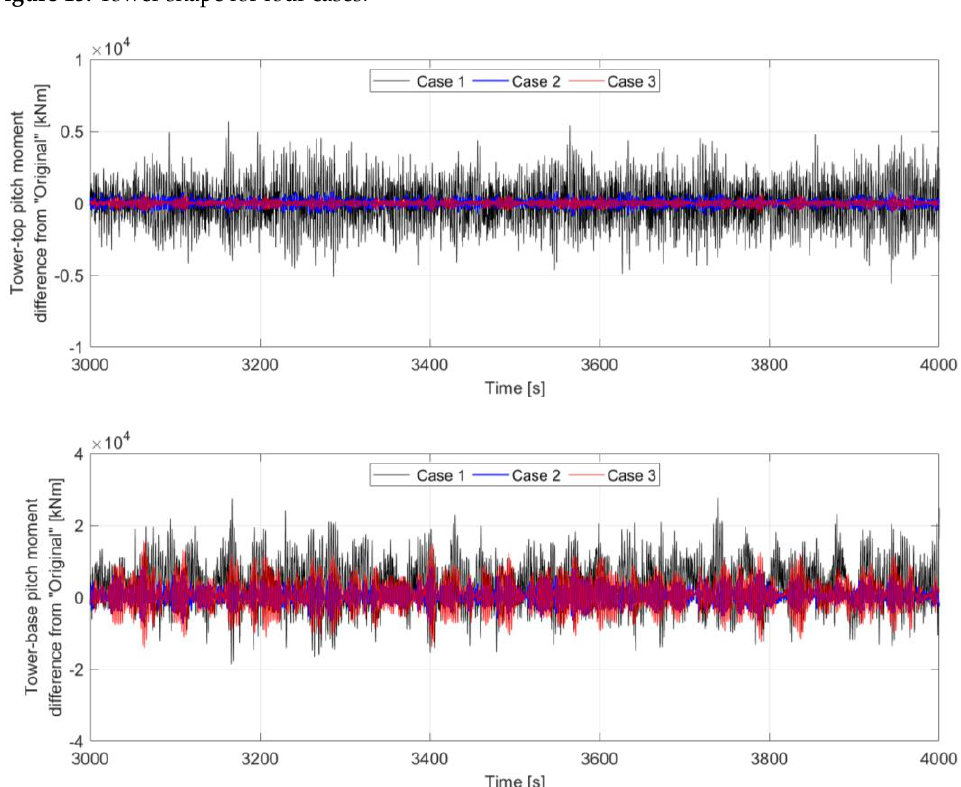
Figure 15. Tower shape for four cases.